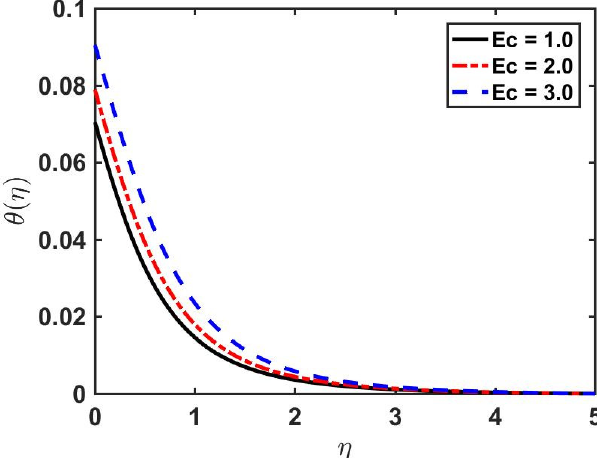
Figure 9. Effect of ( a ) 𝑫 𝟏 and of ( b ) 𝑬 𝟏 on 𝜽(𝜼) .